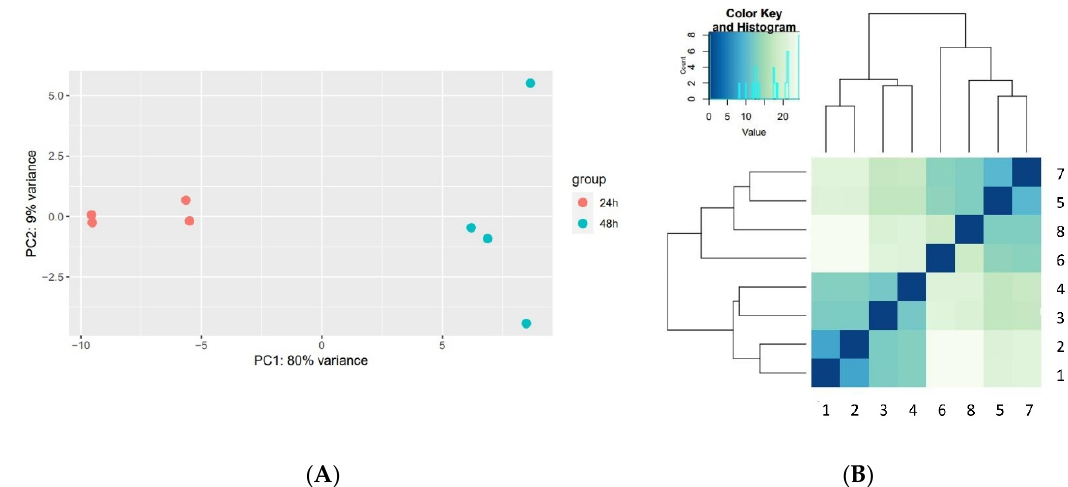
Figure 2. PCA and heatmap plots of dual RNA samples collected 24 and 48 hpi. ( A ) PCA plot and ( B ) distance heatmap. Mice infected with 1000 LD 50 of Y. pestis Kimberly53 strain were sacrificed, lungs were collected and used for RNA extraction. Samples were sequenced individually and the results were used for PCA plot and for heatmap showing gene expression changes induced after 24 or 48 hpi. ( A ) Orange circles—24 hpi; blue circles—48 hpi. ( B ) Samples numbers correspond to those in Table 1. Scale bar in ( B ) shows z-score of normalized read counts (CPM).